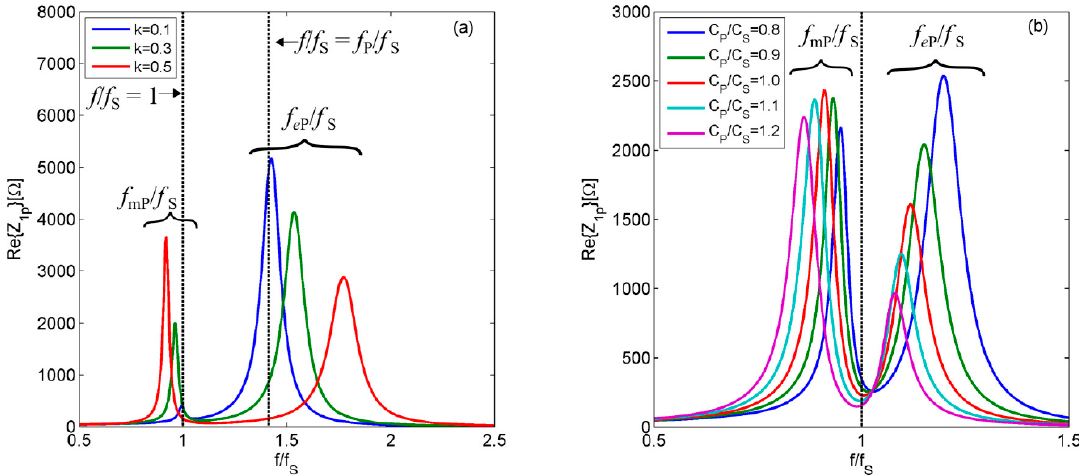
Figure 2. ( a ) Re{ Z 1 P } versus the normalized frequency f / f S for different values of k and for C P / C S = 0.5. ( b ) Re{ Z 1 P } versus the normalized frequency f / f S for different values of C P / C S and for k =